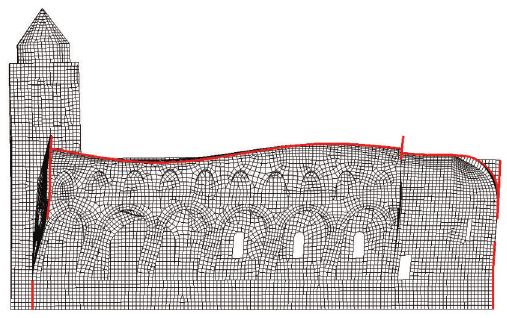
Figure 8: Linear dynamic analysis: longitudinal section of the eigen-mode, no. 7.